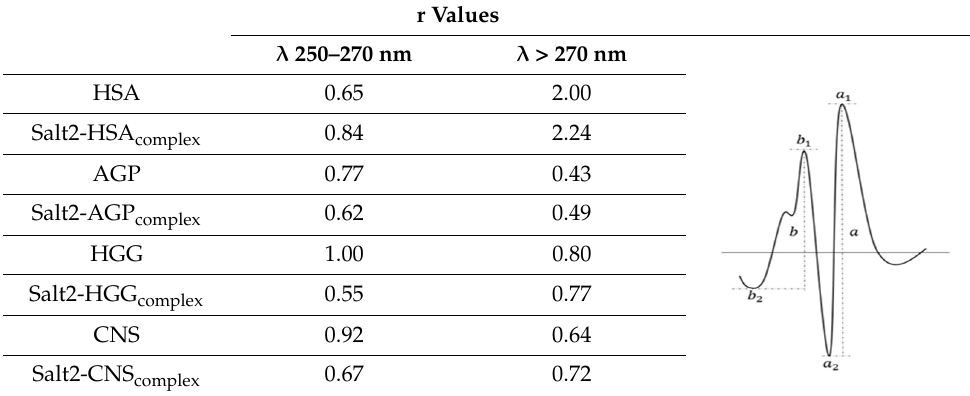
Table 3. r values, calculated from the second derivatives differential absorption spectra of phenyl- alanyl, tyrosyl/tryptophanyl residues of HSA, AGP, HGG and CNS in the presence of Salt2; 8:1 molar ratio, letters (a,b)—peaks height. r Values λ 250–270 nm